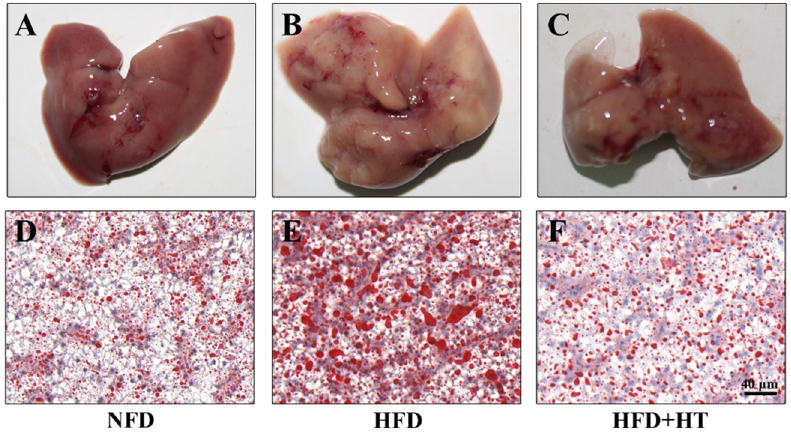
Figure 2. Histological examination of liver in spotted seabass ( L. maculatus ) fed the test diets for 8 weeks. Representative photographs ( A – C ) and oil red O-stained sections ( D – F , scale bar = 20 μ m).